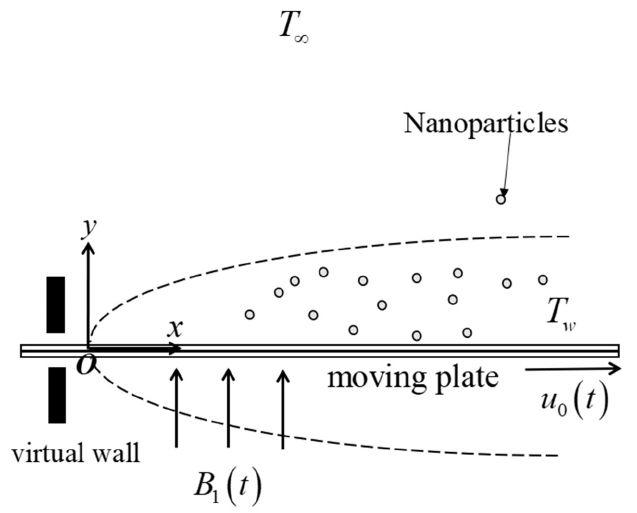
Figure 1. The physical model.